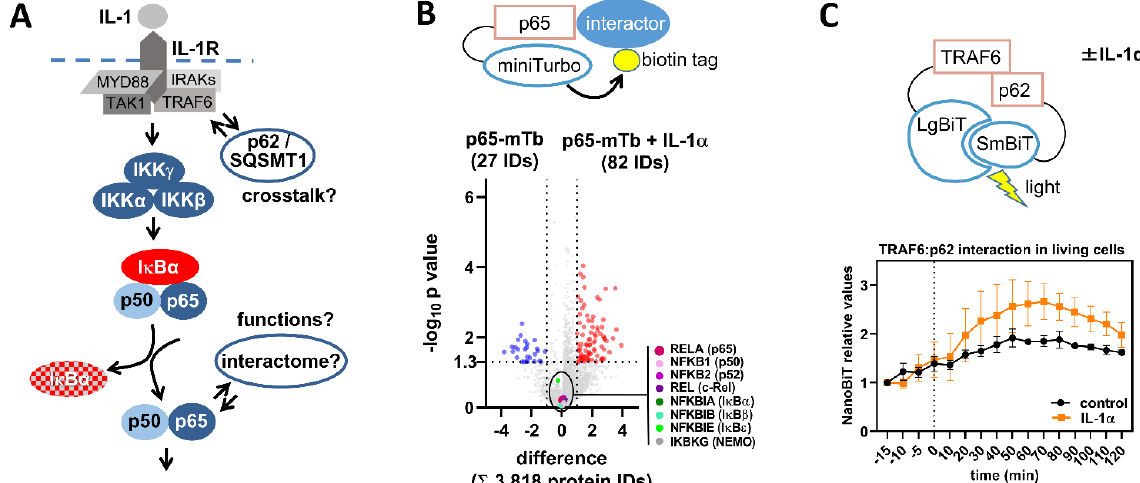
Figure 5. Global or pairwise monitoring of protein/protein interactions in the NF ‐κ B system in living cells. ( A ) Scheme showing established and putative protein/protein interactions of the canonical NF ‐κ B pathway. ( B ) The scheme shows the p65 ‐ miniTurbo (p65 ‐ mTb) fusion protein that was transiently transfected in HeLa cells using a doxycycline ‐ inducible vector system. Expression was induced by 1 μ g/mL doxycycline for 18 h. 24 h after transfection, cells were incubated in 50 μ M biotin for 70 min and were left untreated or were stimulated with IL ‐ 1 α for the last 60 min. Biotinylated proteins were purified from cell extracts using streptavidin ‐ agarose beads and identified and quantified by LC ‐ MS/MS using a TimsTOF system. The Volcano plot shows the differences of the mean protein intensities on the x ‐ axis and the results of Student’s T ‐ test on the y ‐ axis comparing untreated with IL ‐ 1 α‐ treated conditions. Mean protein intensities were determined from two biological and three technical replicates per condition. Out of 3818 proteins identified in total, 109 were found to differentially bind to p65 ‐ mTb upon IL ‐ 1 α treatment (based on a two ‐ fold cut ‐ off and a p value of ‐ log 10 ( p ) ≤ 1.3, red and blue colors), while p65 and seven further components of the canonical NF ‐κ B pathway were readily detected and evenly present in samples from unstimulated or stimulated cells. This approach holds great potential to comprehensively uncover stable, transient, and weak interactions of NF ‐κ B components with cellular proteins in healthy or diseased conditions. ( C ) HEK293T ‐ IL1R1 cells, stably expressing the IL ‐ 1 receptor type 1, were co ‐ transfected with doxycycline ‐ inducible vectors encoding TRAF6 ‐ LgBiT and p62 ‐ SmBiT. Protein ‐ expression was induced by doxycycline (1 μ g/mL) for 30 h. Promega NanoBIT Live Cell Substrate ® was added to allow detection of luciferase activity in living cells. After 15 min of baseline measurement (minute = 0, dotted line), IL ‐ 1 α (10 ng/mL) was added to three of the dishes as shown (yellow), while further three dishes remained untreated (black). The data were normalized to the first measurement and presented as means ( n = 3).